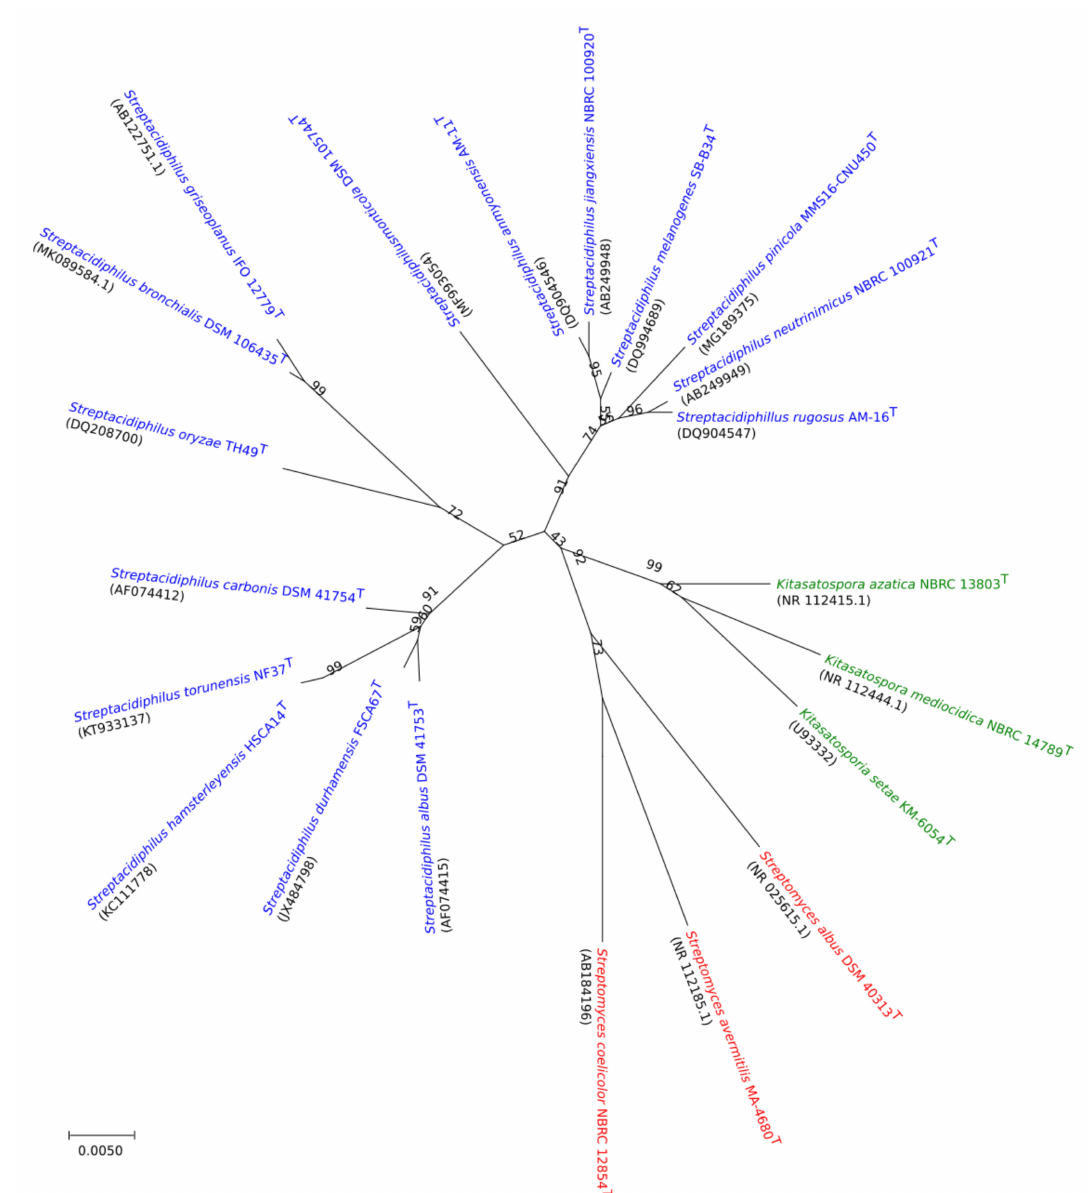
Figure 1. Neighbor-joining tree based on 16S rRNA gene sequences showing the relationships between 15 currently recognized species of Streptacidiphilus . Numbers at the nodes represent the bootstrap support (%), and the scale bar the substitutions rates per nucleotide